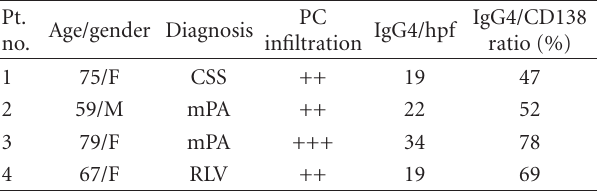
Table 3: Laboratory di ff erence between IgG4-TIN patients with glomerular lesions and those without glomerular lesions.